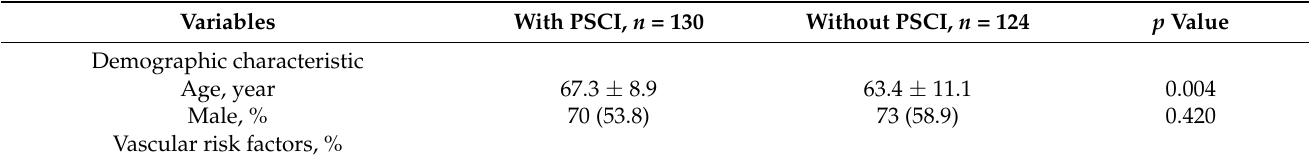
Table 2. Baseline data of the patients with and without